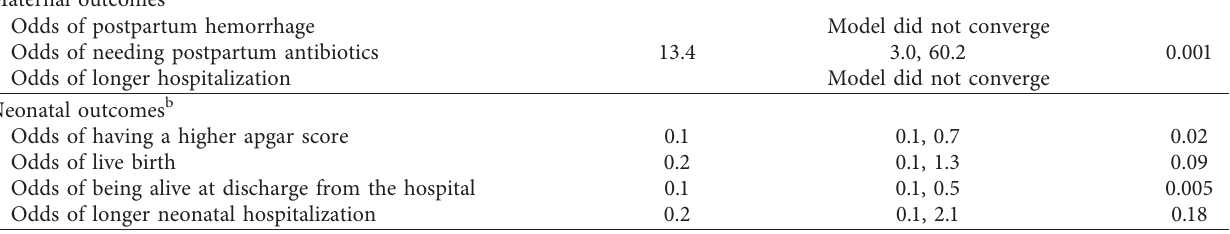
(B) Individual logistic regressions, adjusted for significant findings in Table 4, to determine association of cesarean birth with outcomes significant in bivariate comparisons (Table